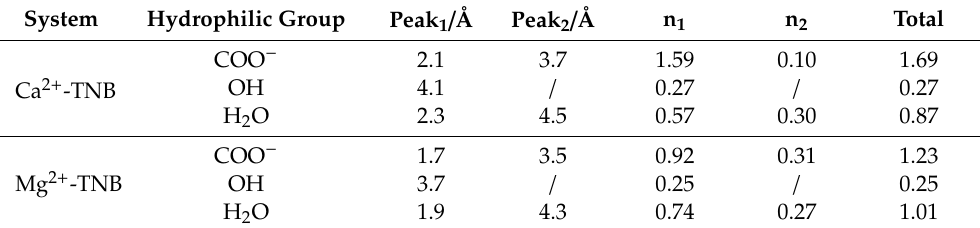
Figure 5. Radial distribution functions of ( a ) Ca 2 + and ( b ) Mg 2 + associated with O atoms of COO − and O atoms of hydroxy and water molecules. Table 3. Radii of the first and second coordination shells around Ca 2 + / Mg 2 + and coordination numbers of association with COO − and OH of TNB and water